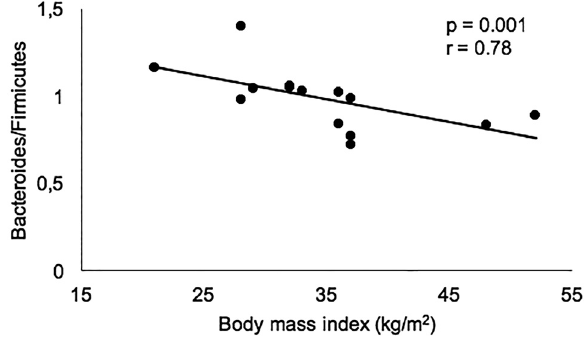
Figure 1: Correlation between BMI and Bacteroides/Firmicutes ratio for prediabetic subjects; Spearman ’ s probability (p) and correlation (r), correlation is signi fi cant at the 0.01